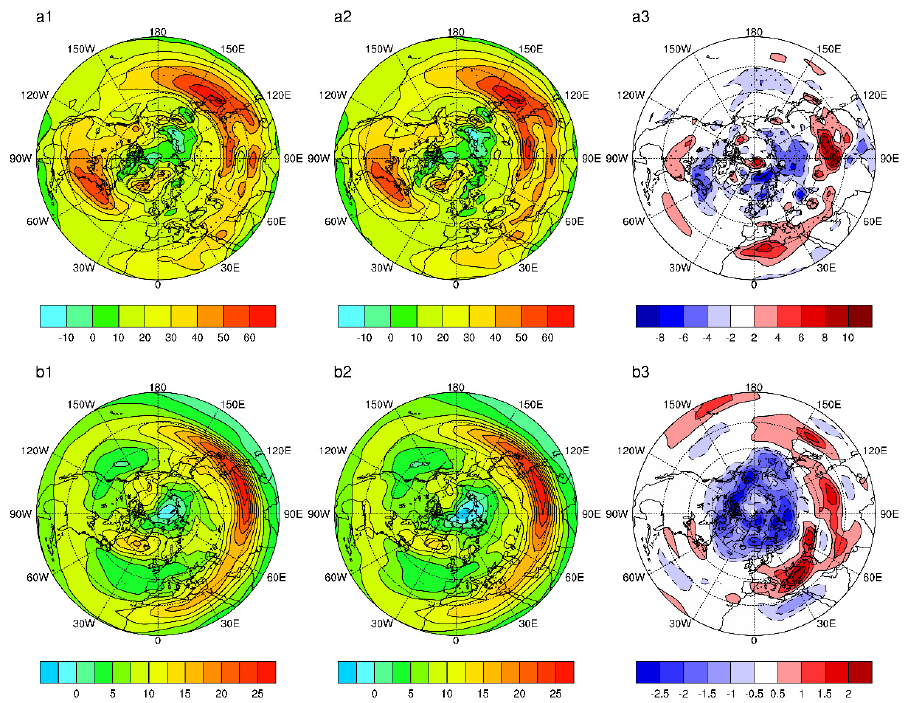
(cid:82) P t − ∂ T / ∂ ydp between surface-500 hPa ( a1 , a2 ) and 500–100 hPa ( b1 , b2 ) Figure 6. The distribution of P b during the P1 and P2 periods and their differences between the two periods (P2–P1, ( a3 , b3 )). (Units: hPa · K · m − 1 · 10 − 4 . The dotted areas represent that the differences pass the significance test of 95%. The outermost latitude is 15 ◦